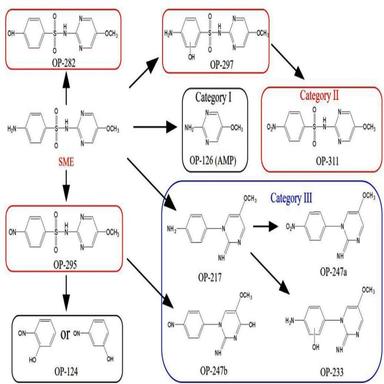
The proposed degradation pathway of sulfameter (SME). The oxidation products circled in black, red and blue are classified in Category I, Category II, and Category III, respectively.